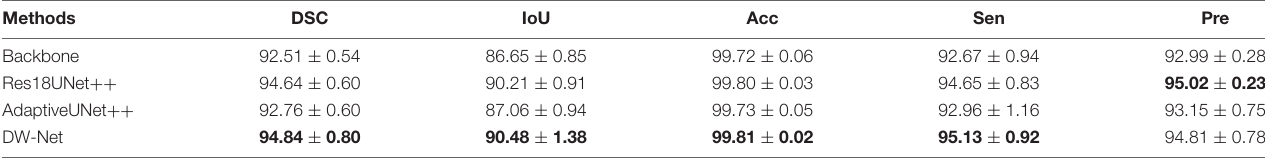
TABLE 3 | Ablation experiments (mean ± SD).